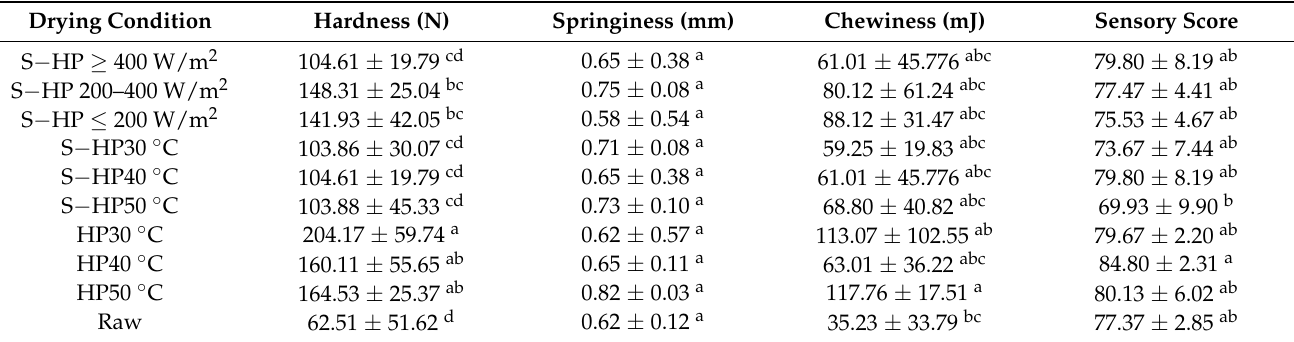
Table 7. Textural indices under different drying